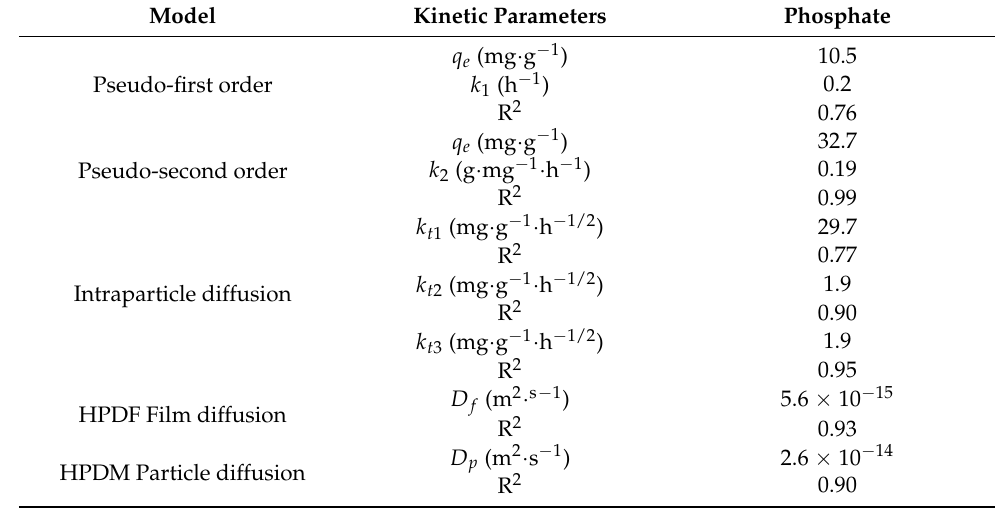
Table 5. Kinetic parameters of the phosphate adsorption onto Mn 2+ /Zn 2+ /Fe 3+